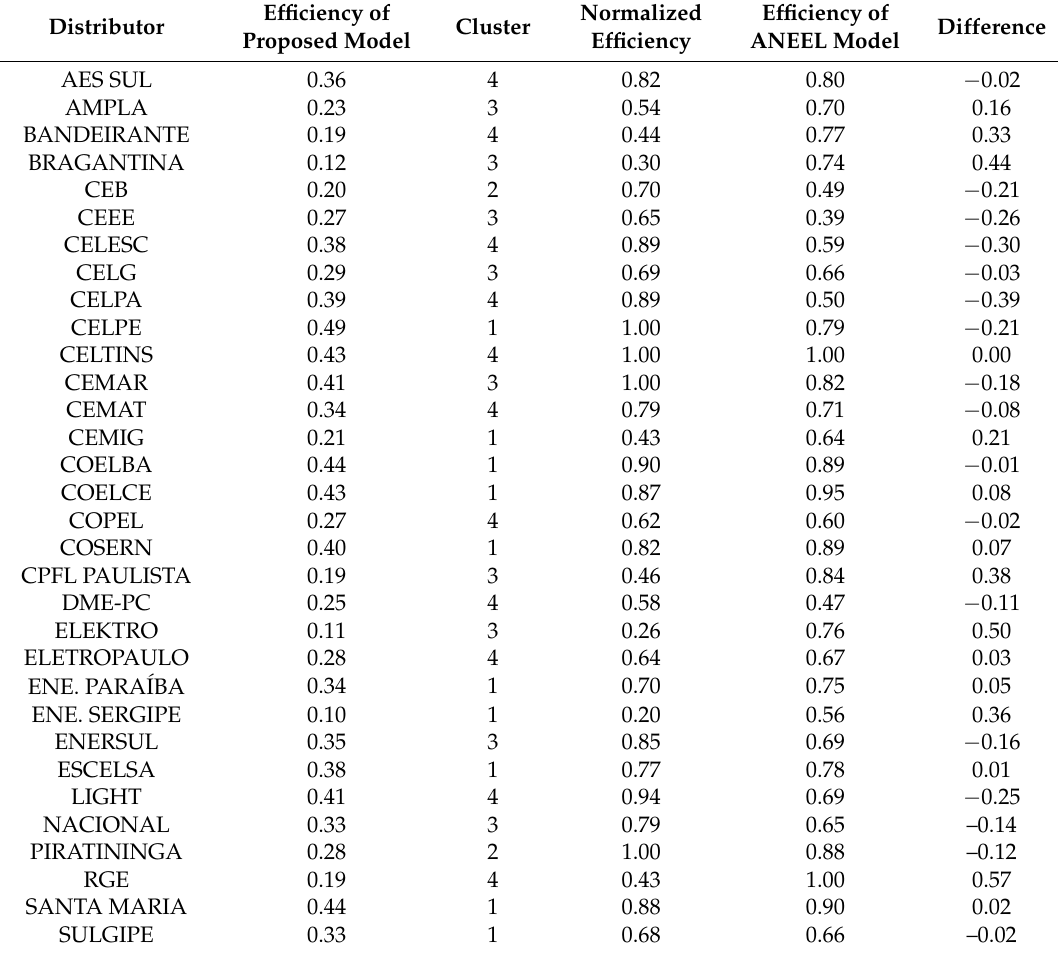
Table 2. Significance levels for factors in